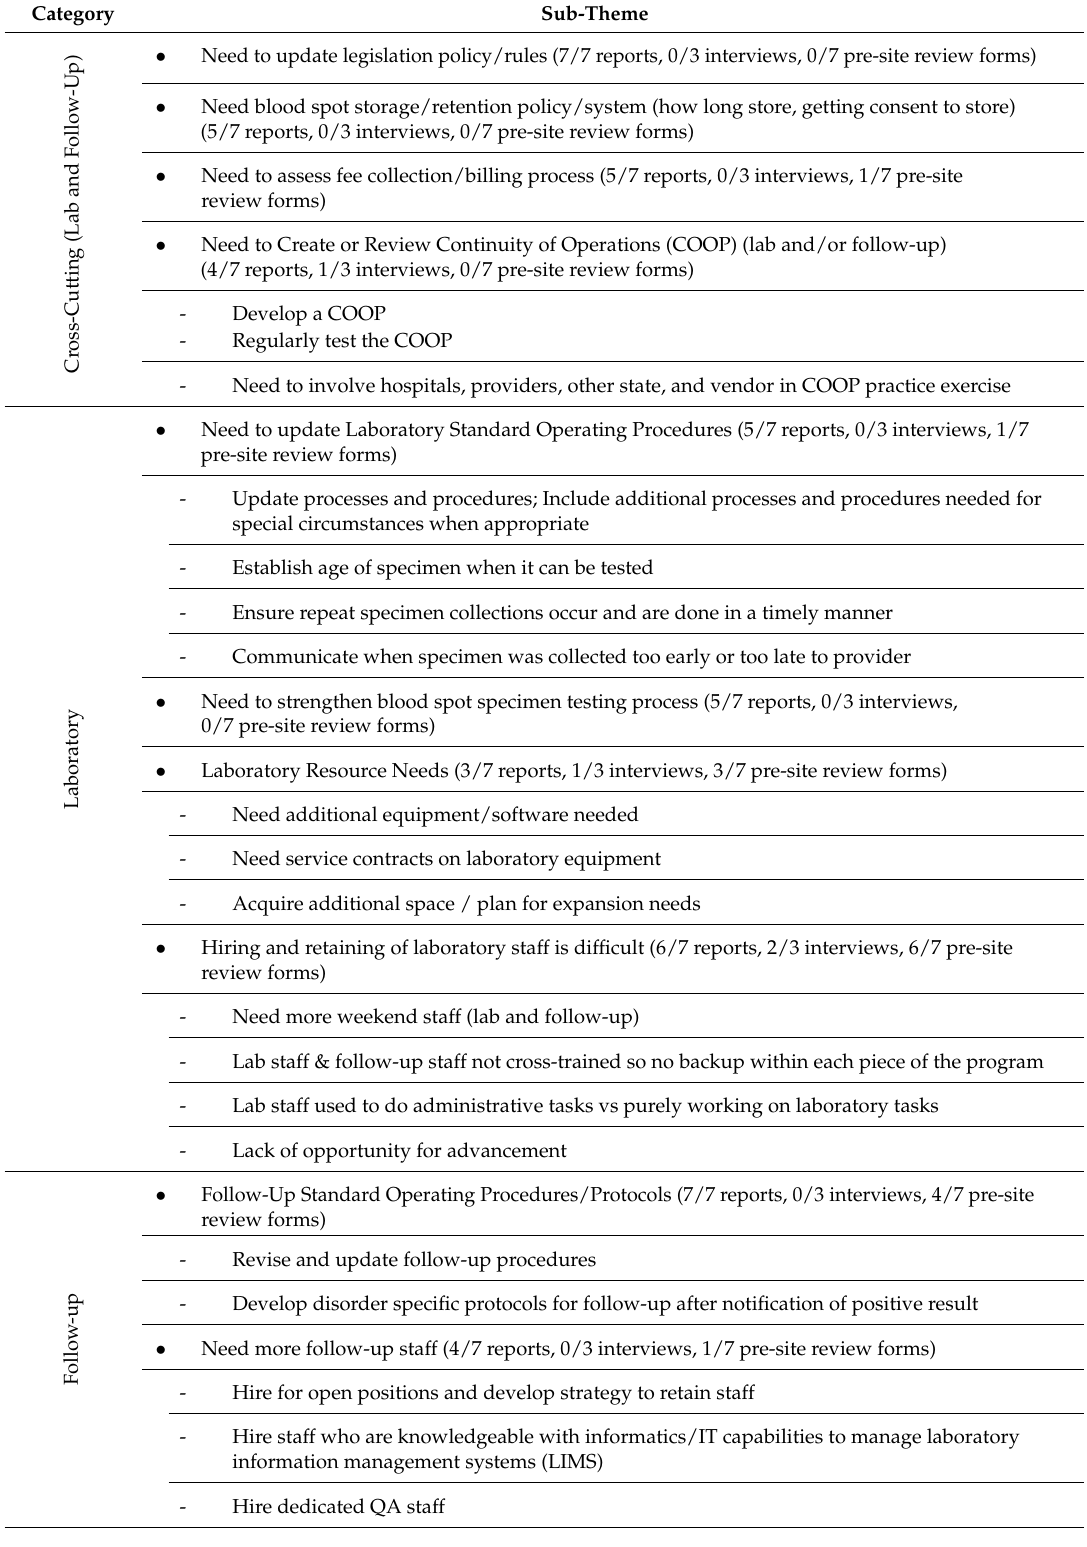
Table 5. Needs identified in State Newborn Screening Program Site Reviews: Operations in State Newborn Screening Program Needs themes identified (Number of times reported in site review report, individual interview, and pre-site review